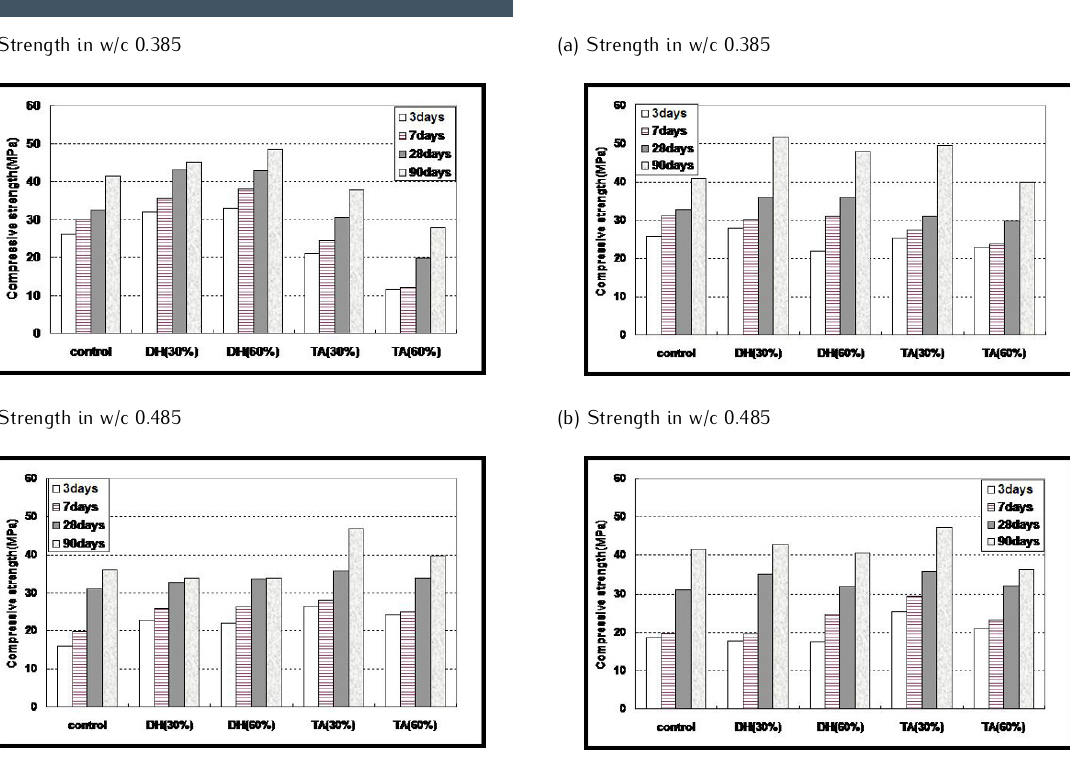
Figure 7. Compressive strength with different mix conditions (without HWRA).